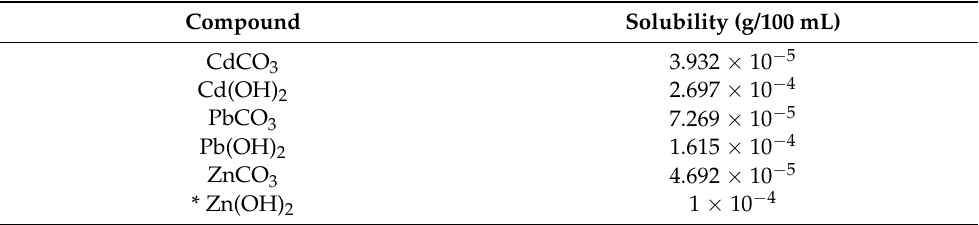
Table 2. Solubility of CdCO 3 , PbCO 3 , and ZnCO 3 , and Cd(OH) 2 , Pb(OH) 2 , and Zn(OH) 2 in water at 20 ◦ C based on IUPAC Solubility Database